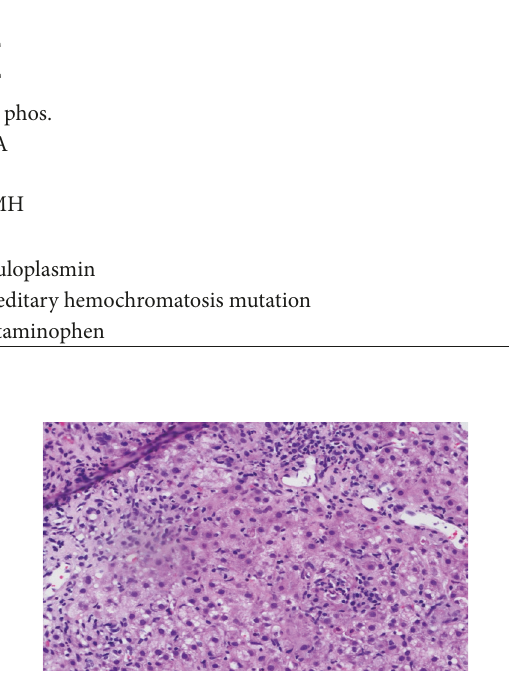
Figure 1: Liver biopsy. Severe inflammatory response comprised of neutrophils and lymphocytes with hepatocellular necrosis. No plasma cells or eosinophils and no bile duct damage or fibrosis. H&E stain, × 400.